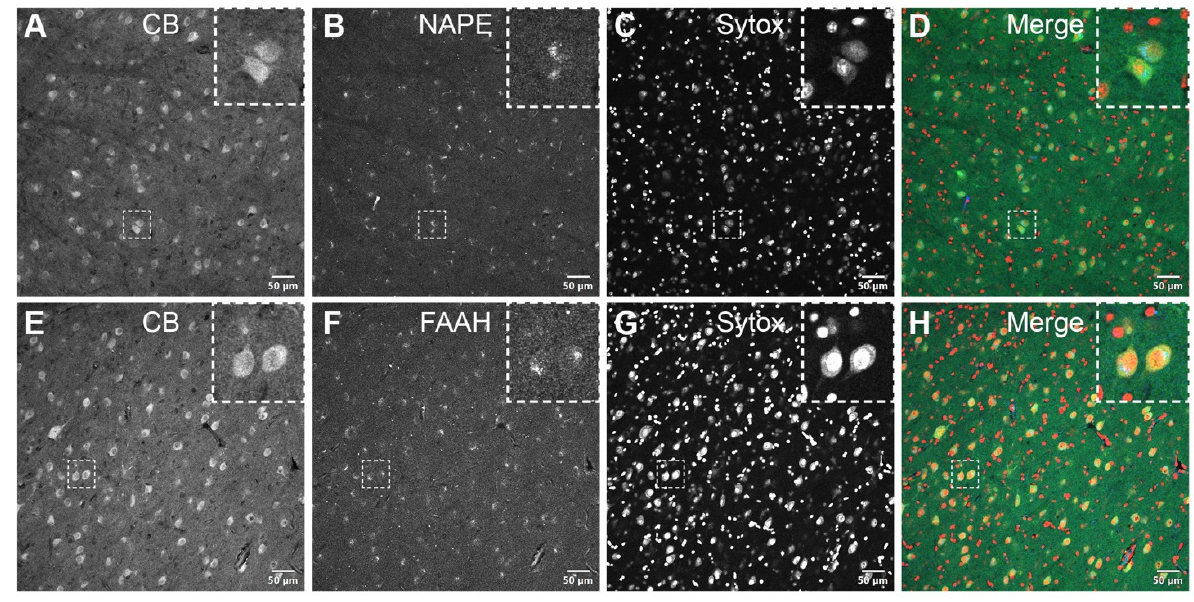
Figure 4. Double-label immunofluorescence illustrating the co-localization of eCB-synthesizing—NAPE-PLD ( A – D , insets)—and degrading—FAAH ( E – H , insets)—enzymes with calbindin in the somatodendritic compartment of PI neurons. The dashed squares in panels A – H indicate representative cells displayed at a higher magnification in the respective insets (3 × digital zoom). Nuclear counterstaining with Sytox orange is shown in the third column of each panel. CB: calbindin-D28k; FAAH: fatty acid amide hydrolase; NAPE-PLD: N -acyl phosphatidylethanolamine phospholipase D. Scale bar = 50 µm.